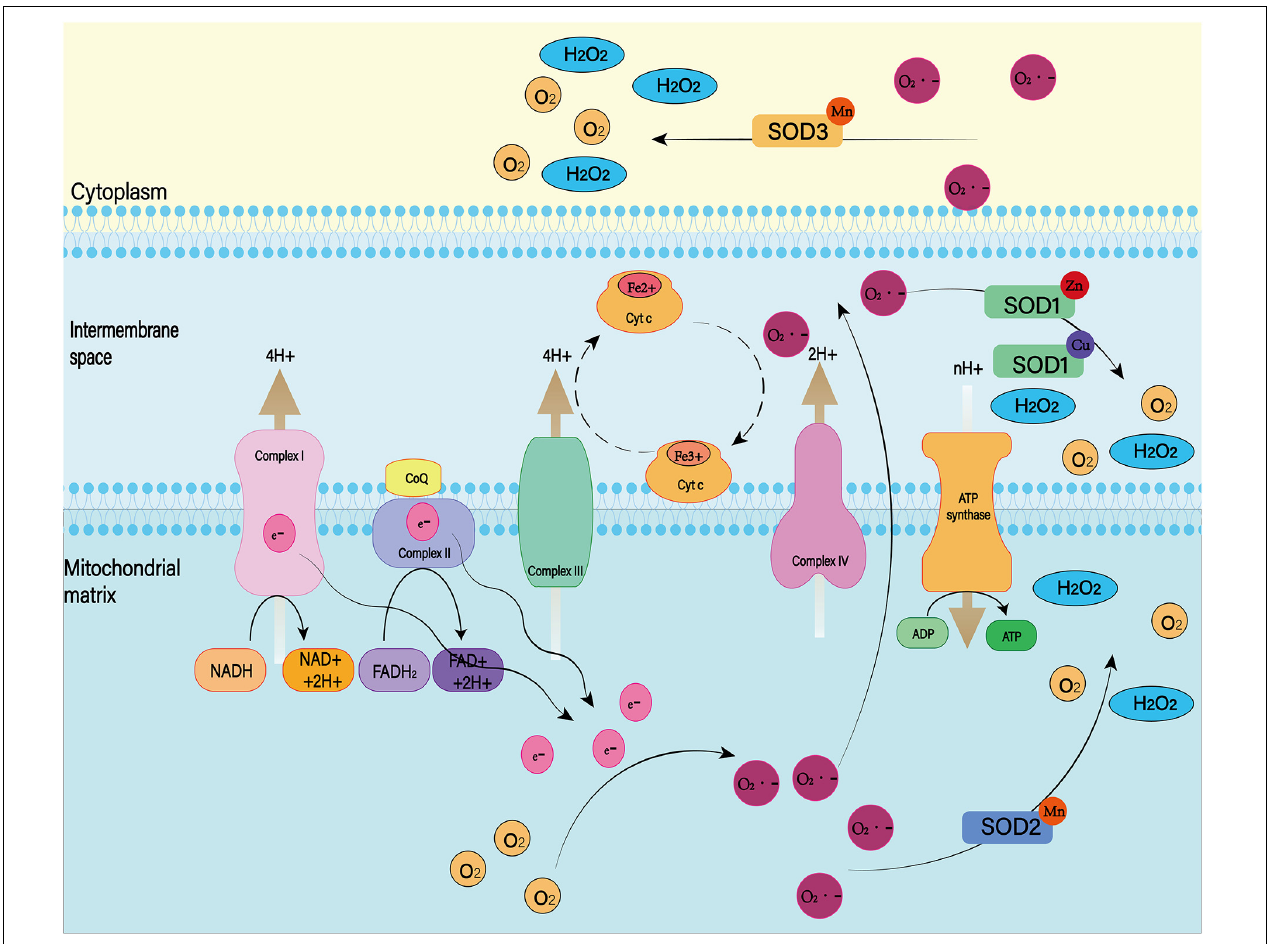
FIGURE 9 | There are many isotypes of SOD. Among them, SOD1, SOD2, and SOD3 play major roles in the cell. Both were able to reduce superoxide to produce H 2 O 2 and O 2 , but they worked in different places. SOD1 exists in the mitochondrial membrane space, SOD2 is distributed in the mitochondrial matrix, and SOD3 is distributed in the cell